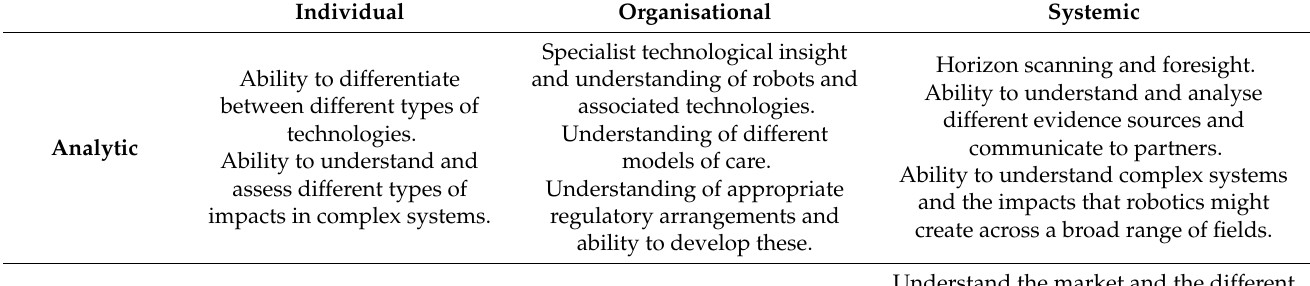
Table 3. Policy capacity requirements to oversee